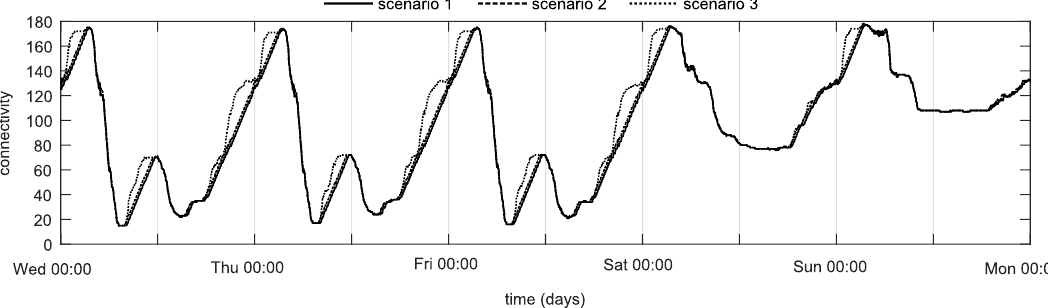
Figure 7. Connectivity of buses on selected weekdays and